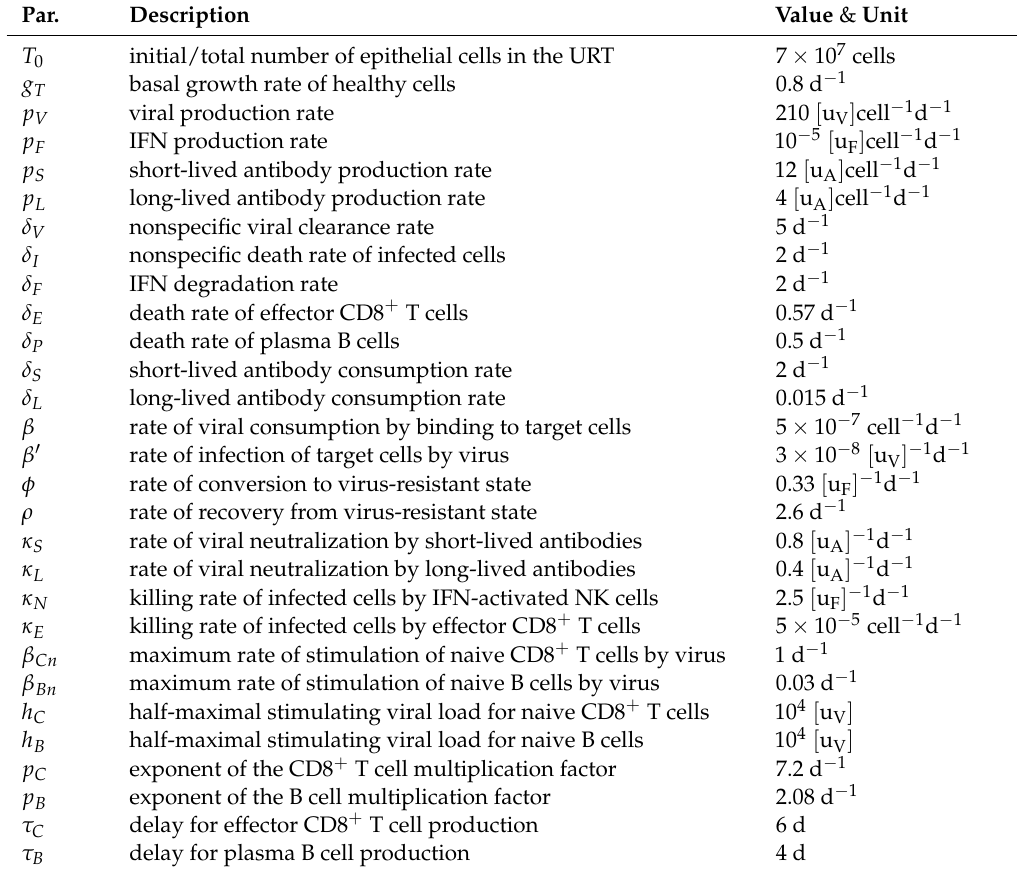
Table 1. Model parameter values for both the target cells—virus-infected cells—free virus (TIV) model and the immune response (IR) model. The values are adopted from one of our earlier study [27] where some of the parameters were obtained from the literature (references provided in [27]) and the rest were obtained by fitting the IR model to experimental data from [29]. [ u V ] , [ u F ] and [ u A ] represent the units of viral load, interferon (IFN) and antibodies respectively. [ u V ] and [ u A ] are EID 50 /mL (50% egg infective dose) and pg/mL. IFN is assumed to be a non-dimensionalised variable in the model, and therefore [ u F ] can be ignored. URT: upper respiratory